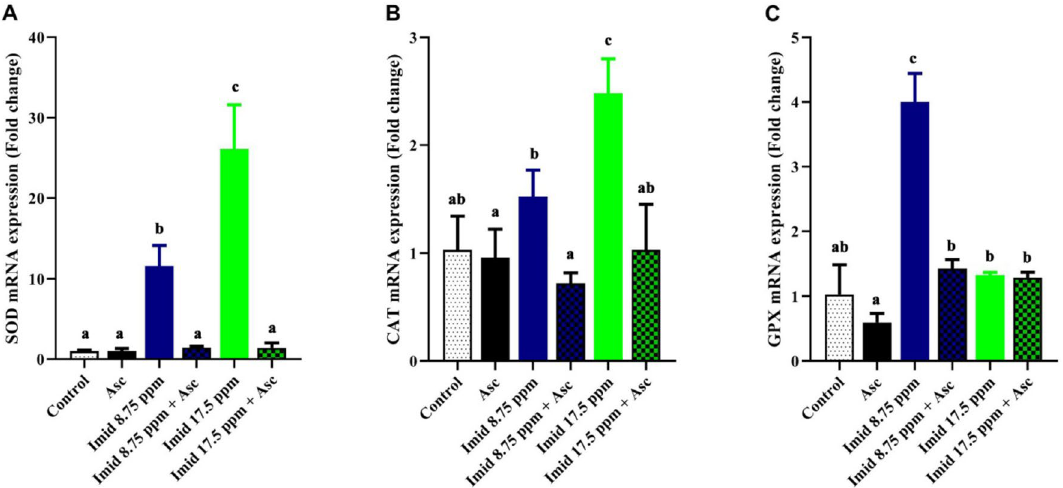
Figure 3. The ameliorative effect of ascorbic acid (Asc) on relative mRNA levels of imidacloprid (Imid)- exposed groups on the liver of O. niloticus . The concentrations of Imid (8.75 and 17.5 ppm) and Asc (50 ppm) were administrated for 21 days. Superoxide dismutase, SOD ( A ), Catalase, CAT ( B ), Glutathione peroxidase, GPX ( C ). Values were expressed as mean ± standard deviation (SD), bars refer to SD, (n = 5 fish). Different letters above the columns indicate significant differences at p < 0.05 between